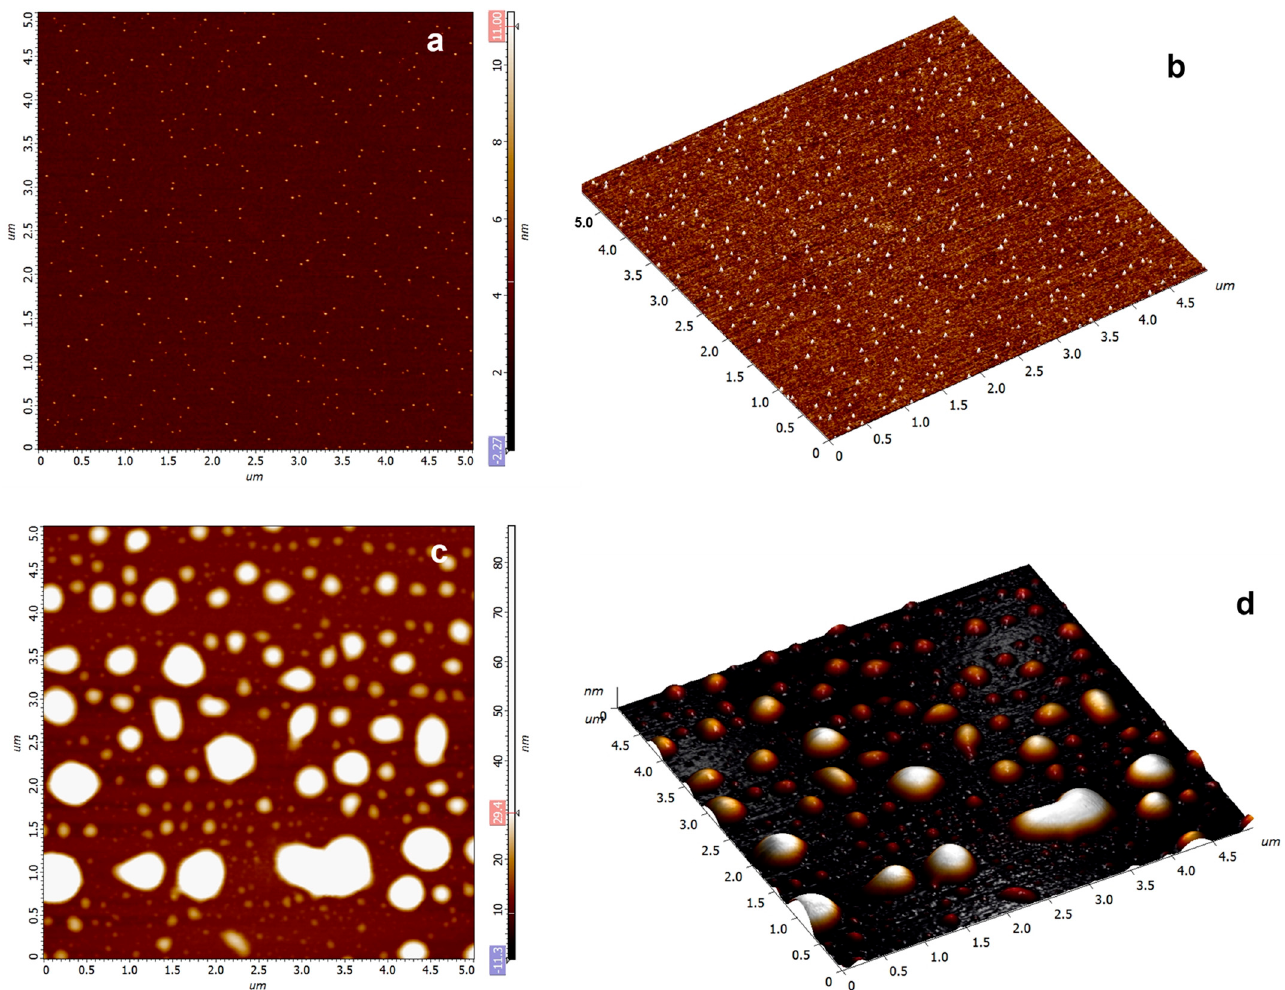
Figure 2. AFM images of PVA ( a , b ) and TEA ( c , d ) after deposition on Si plates by MAPLE, acquired as 2D and 3D renders, respectively. Scan size: 5 μ m. Table 3. Statistical Summary for the roughness parameters of PVA and TEA deposited by MAPLE on polished